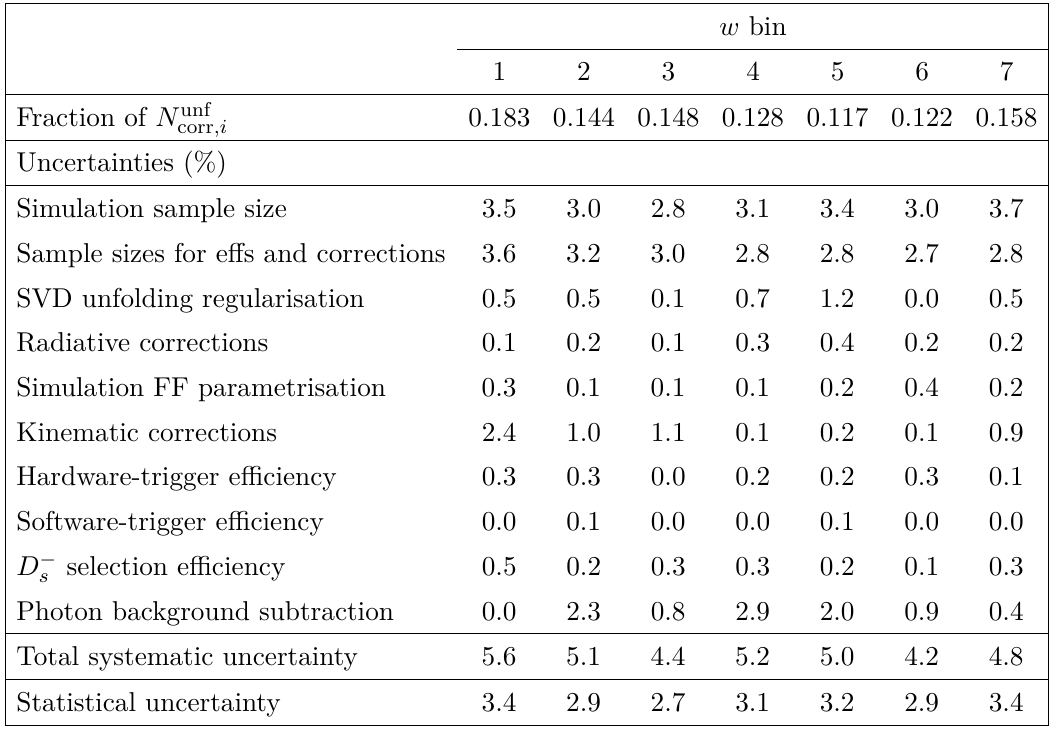
Table 2 . Fraction of the unfolded yields corrected for the global efficiencies, N unf Also shown in this table is the breakdown of the systematic and statistical uncertainties on N unf These are shown as a fraction of the unfolded